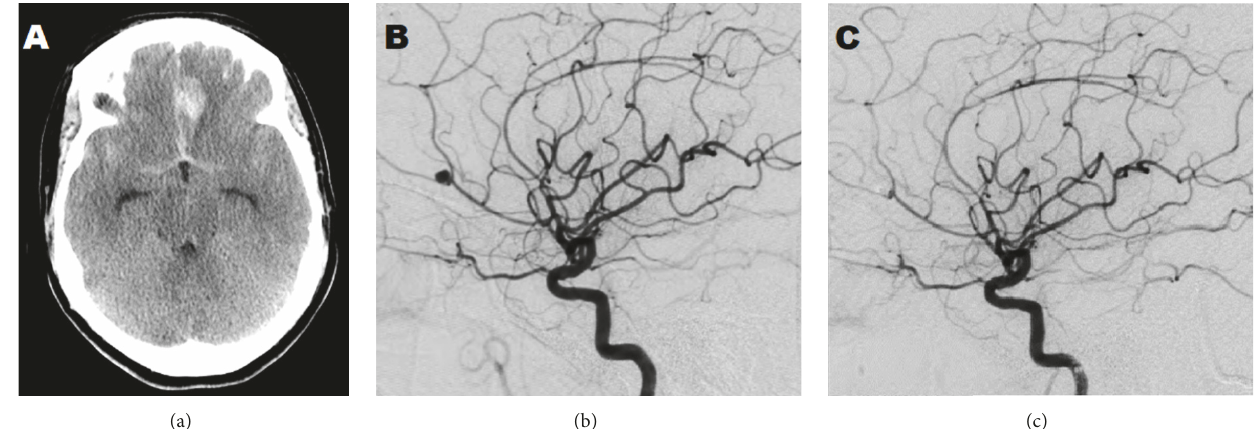
Figure 1: Imaging study upon patient’sarrival at the hospital in 2012. (a) CT head without contrastshowing diffuse subarachnoidhemorrhage that originated from an aneurysm identified by (b) Cerebral angiogram. (c) Cerebral angiogram imaging after coiling of an